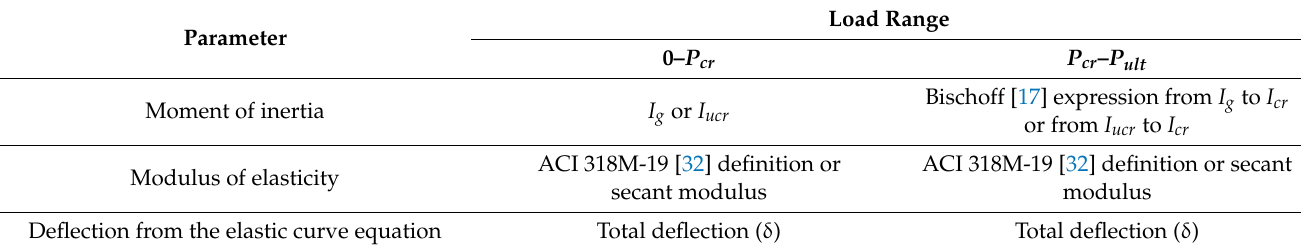
Table 6. Model B for estimating the deflections of FRP RC